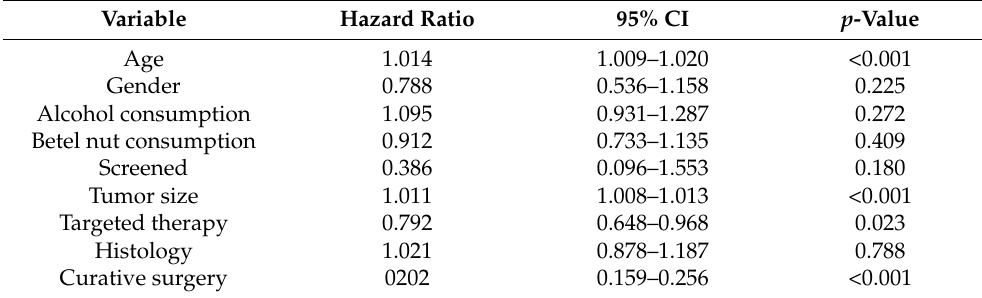
Table 5. Multivariate Cox regression model of prognostic factors of smokers with lung